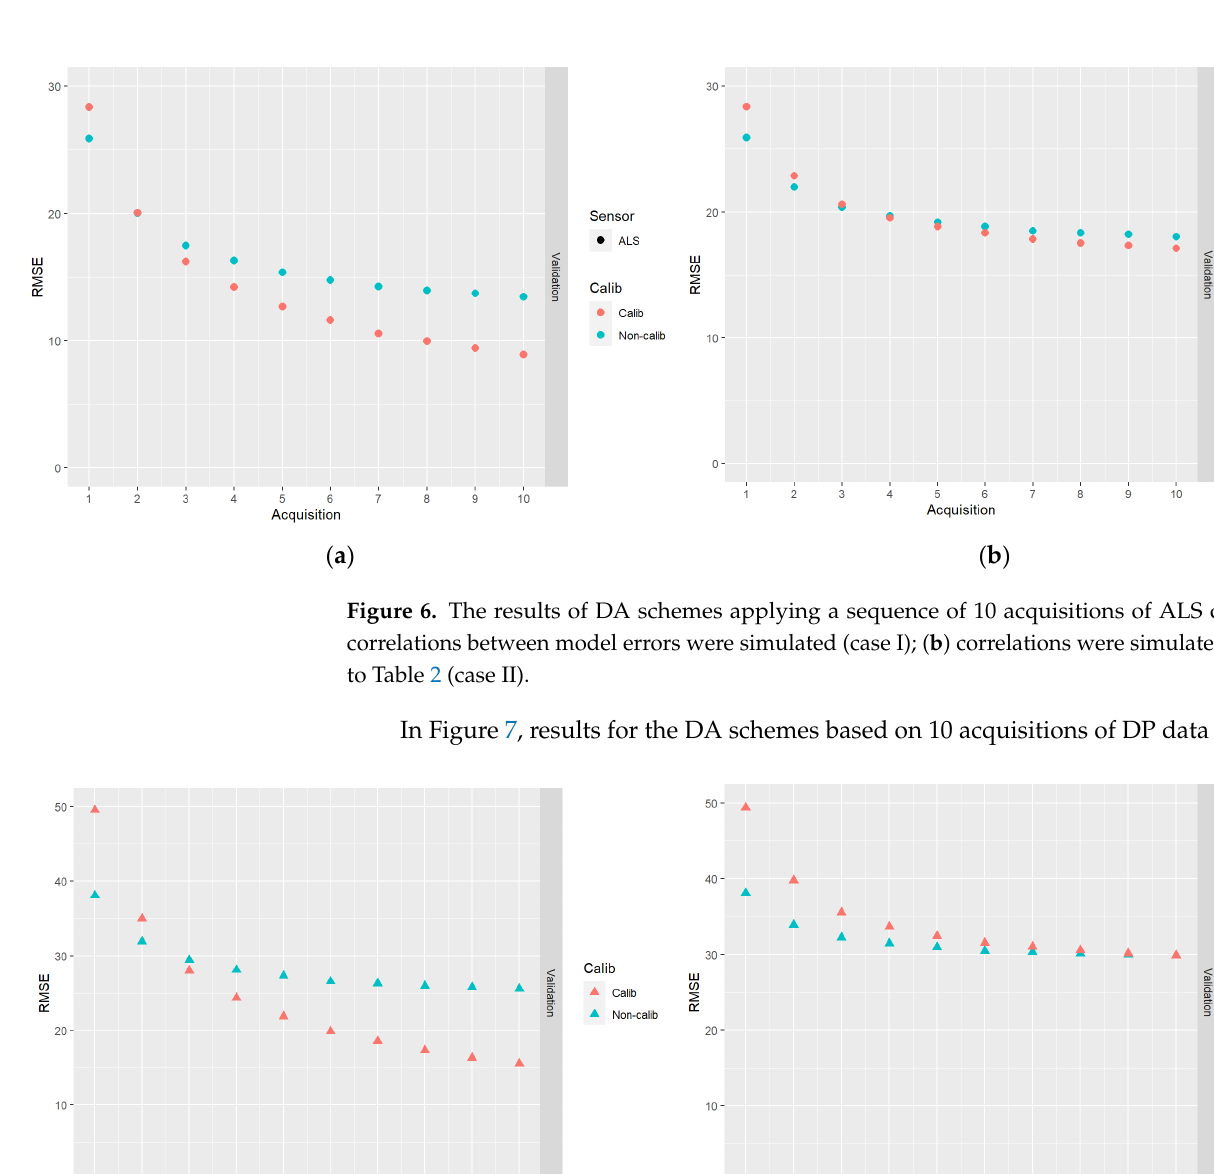
Figure 7. The results of DA schemes applying a sequence of 10 acquisitions of DP data: ( a ) no cor- relations between model errors were simulated (case I); ( b ) correlations were simulated according to Table 2 (case II).